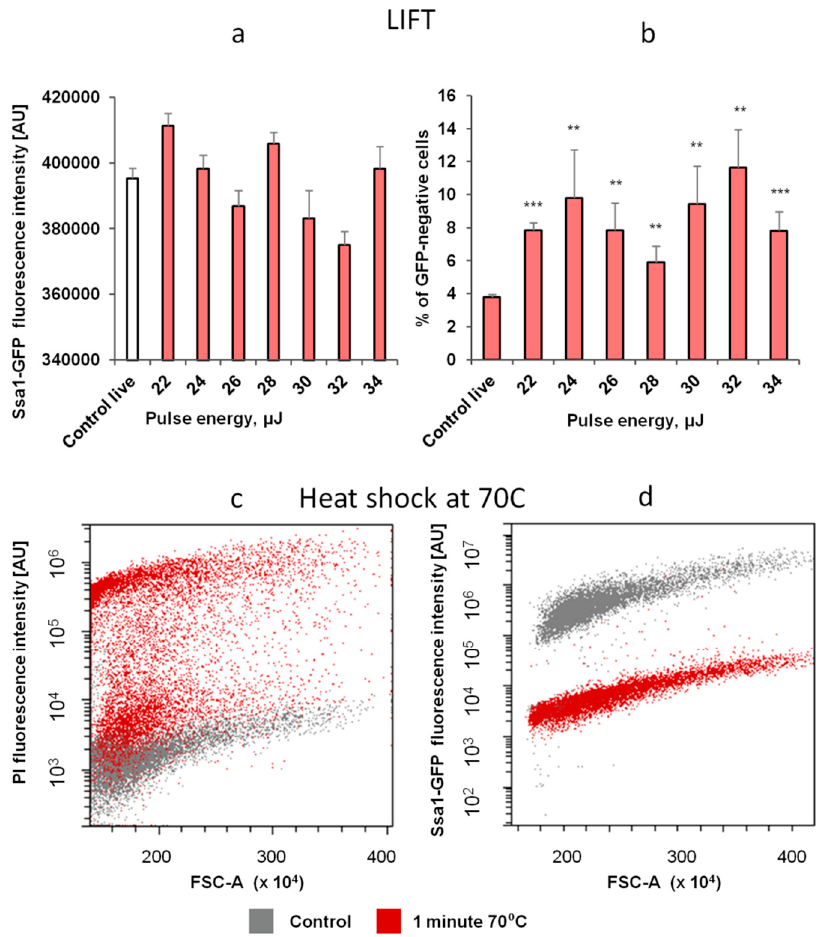
Figure 9. LIFT of Ssa1-GFP cells shows no rise of GFP signal but GFP dimming in a small population of cells, which is also observed in a larger fraction of cells during short heat shock at 70 ◦ C. ( a ) Relation between level of median GFP fluorescence and the laser pulse intensity (in PI-negative cells with noticeable GFP fluorescence) ( b ) Relation between share of cells with diminished GFP signal and the laser pulse intensity ( p ≤ 0.05 (**), p ≤ 0.01 (***), Student’s t -test) ( c , d ) Cytometric analysis of PI ( c ) and GFP ( d ) fluorescence of yeast cells producing Ssa1-GFP after 1 min treatment with the indicated temperature.